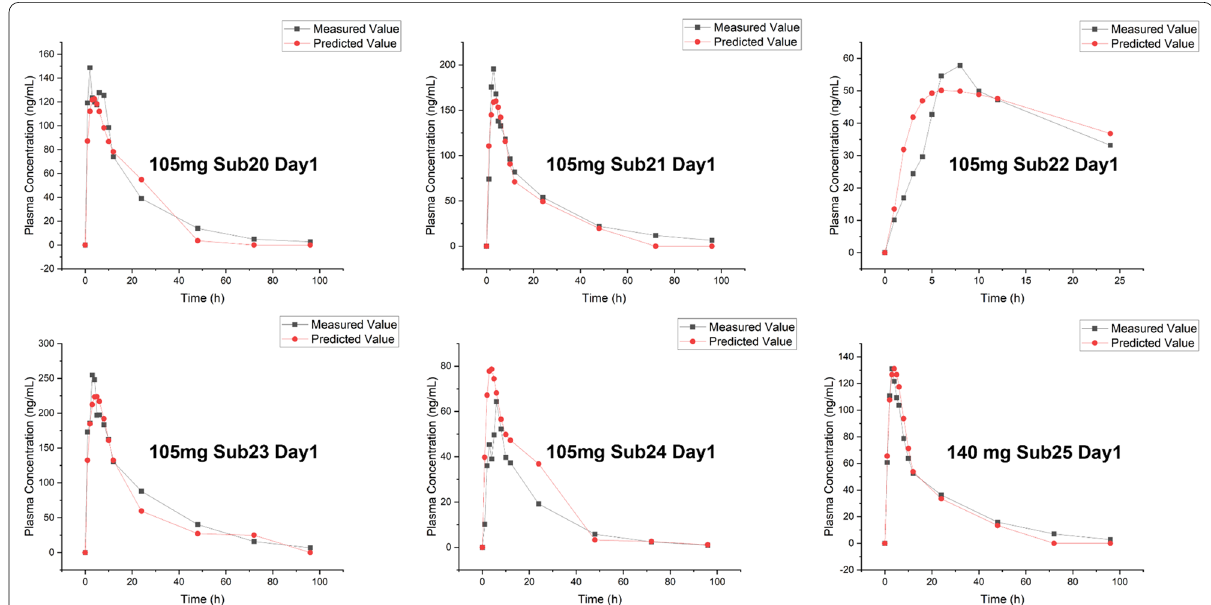
Fig. 6 The predicted and measured time-concentration profiles after single dosing of MET306 in 105 and 140 mg groups